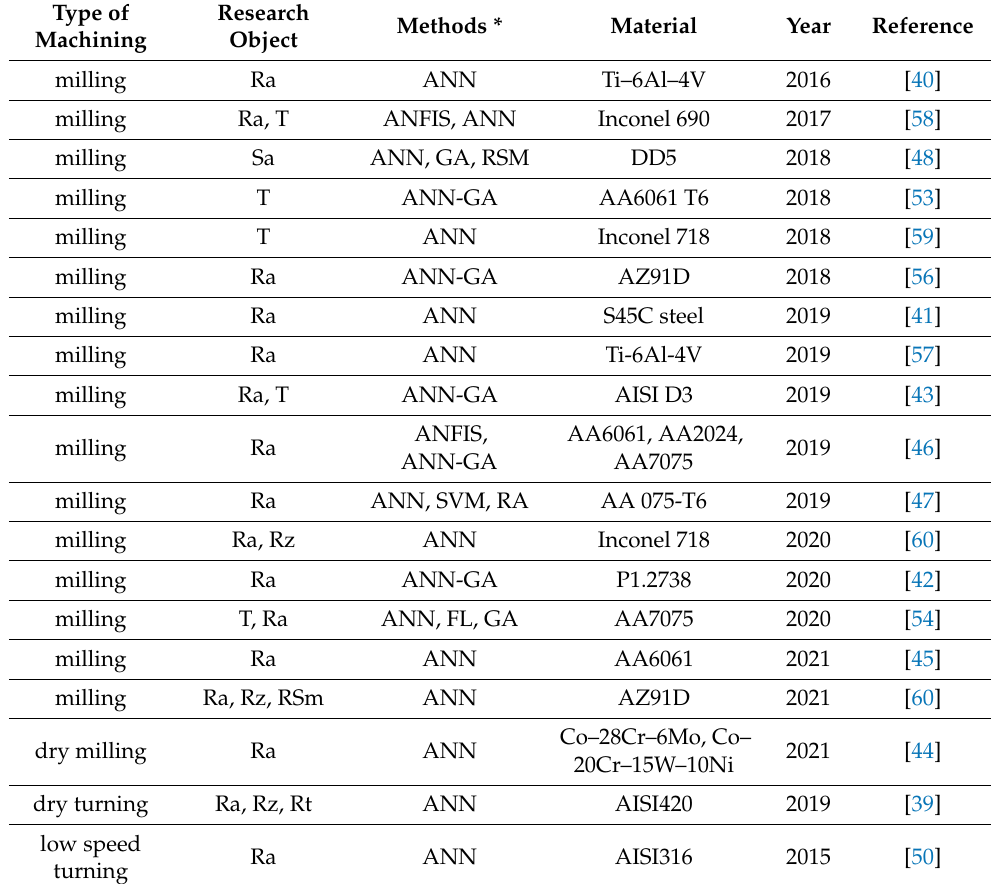
Table 1. Comparison of modelling methods using the ANN for the